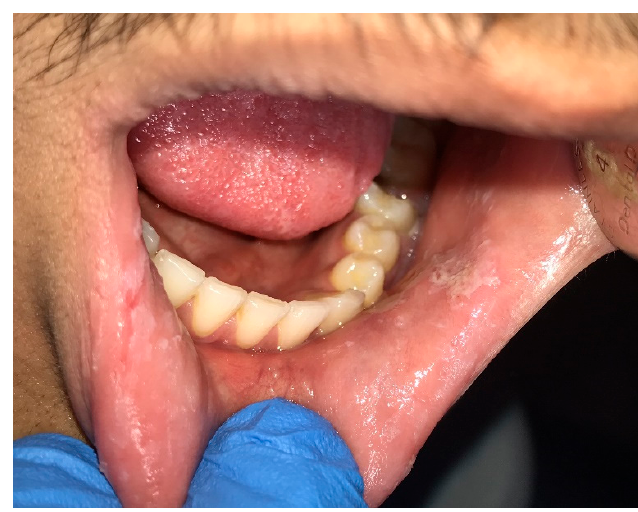
Figure 5. Habitual biting of cheeks and the lower lip.